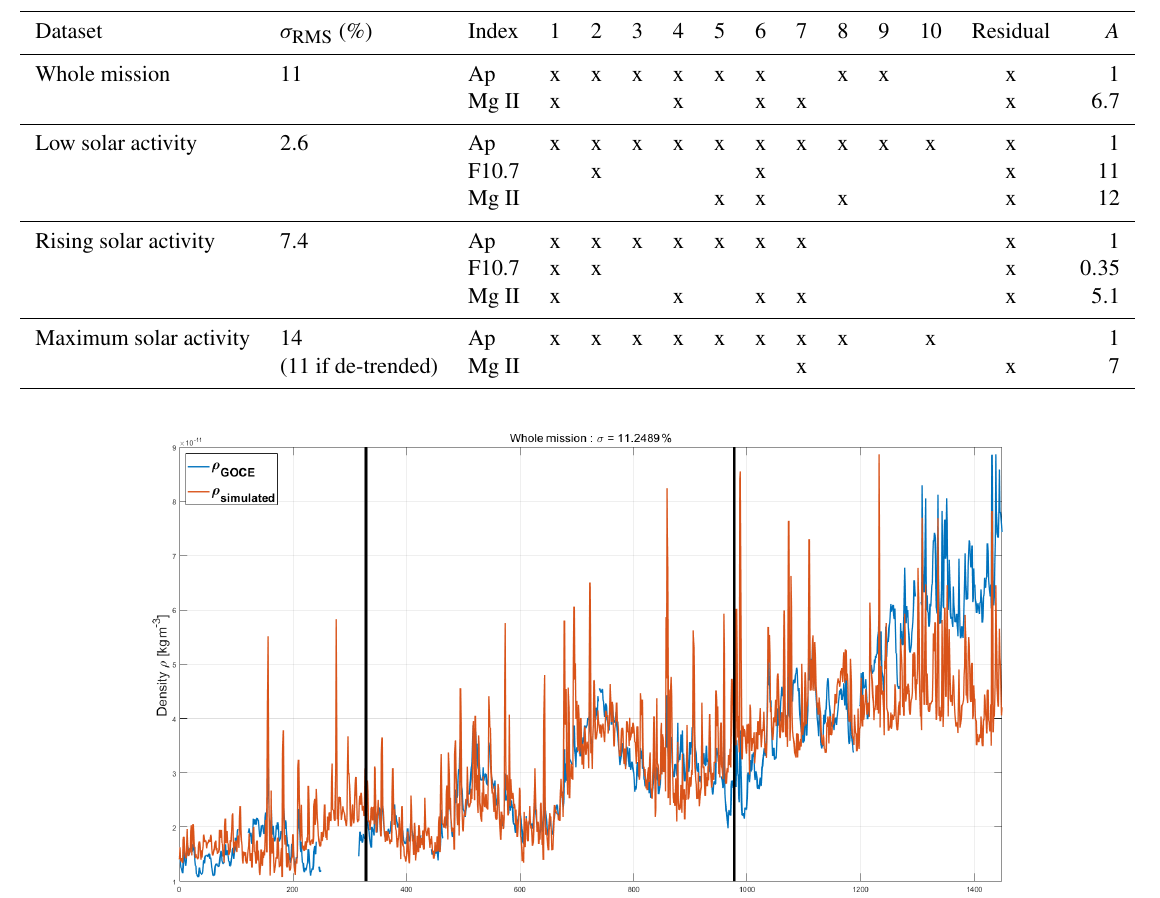
Table 1. Components of optimal synthesized signal for the whole mission and low, rising and high solar activity during solar cycle 24. RMSE σ RMS (normalized to the mean value) and component amplitudes A .